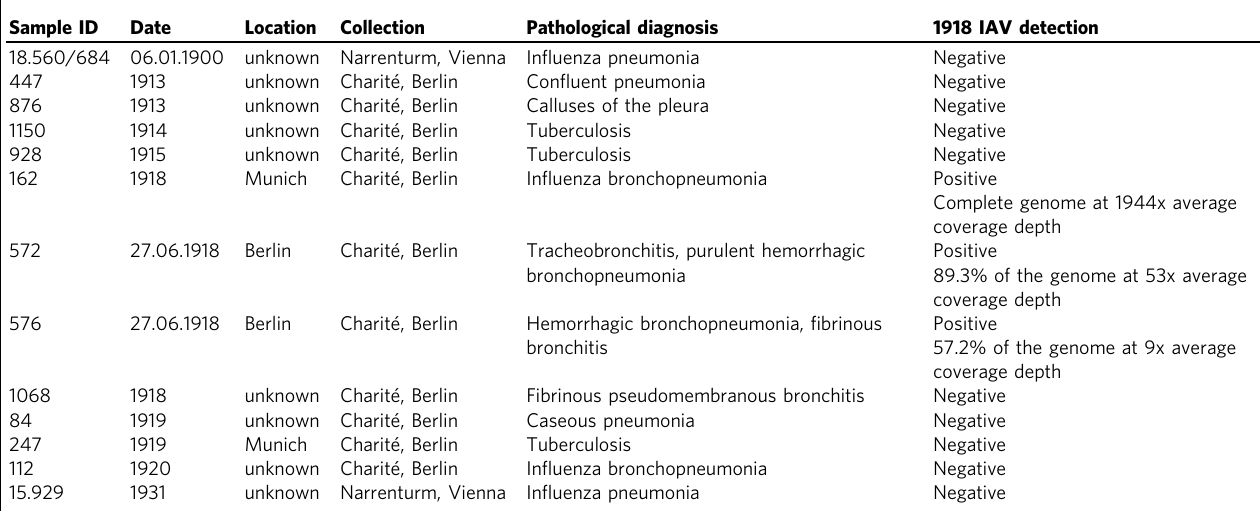
Table 1 Details on the archival samples used in this